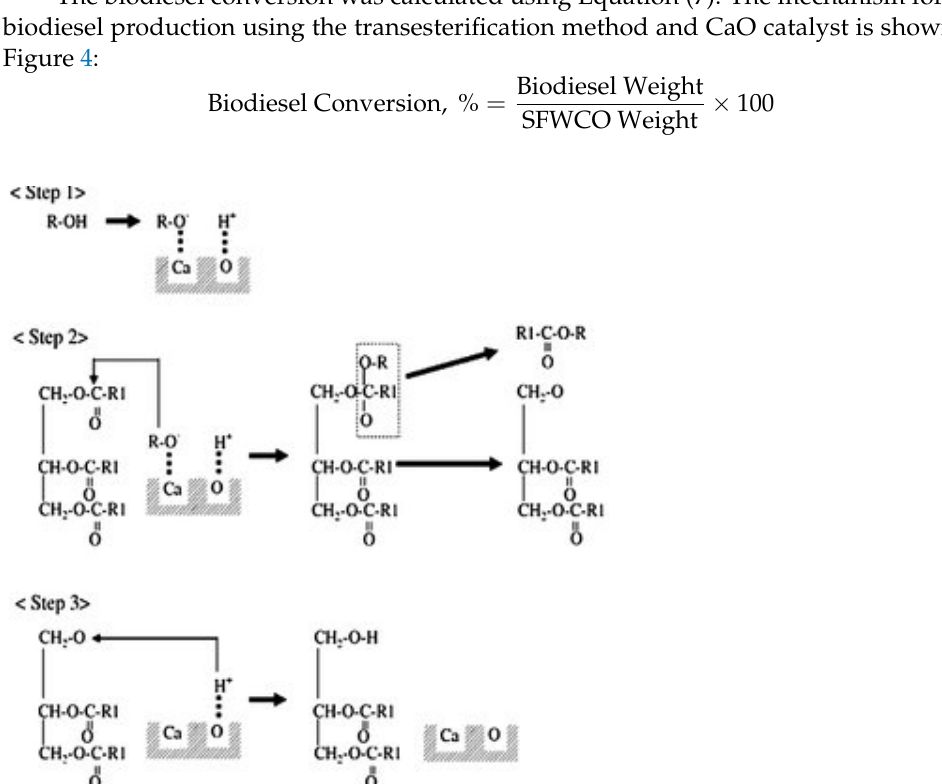
Figure 4 . Mechanism of transesterification reaction using CaO catalyst [25] . Figure 4. Mechanism of transesterification reaction using CaO catalyst